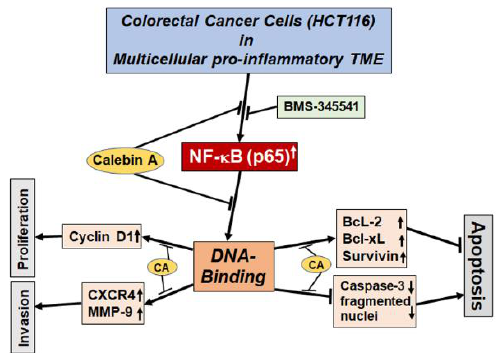
Figure 8. Modulatory impacts of Calebin A on the NF- B signaling pathway in the multicellular TME.